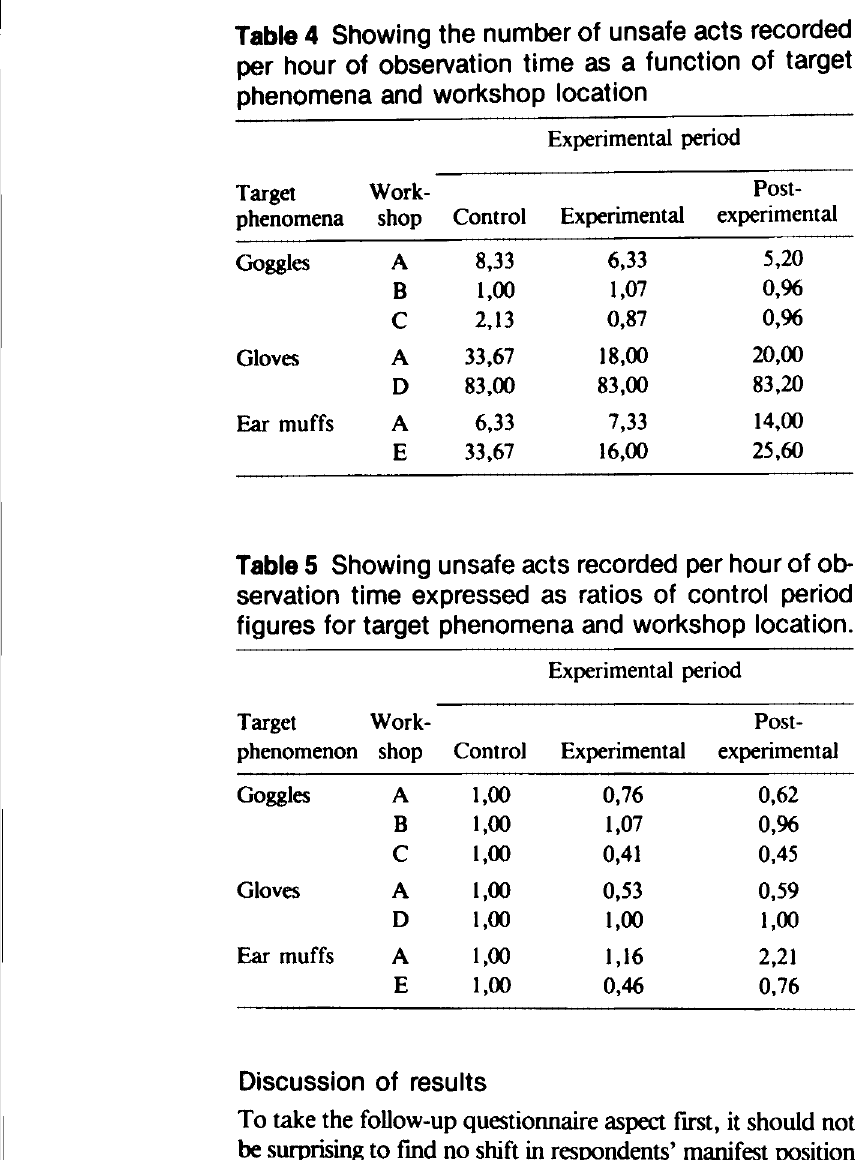
Table 5 Showing unsafe acts recorded per hour of ob servation time expressed as ratios of control period figures for target phenomena and workshop